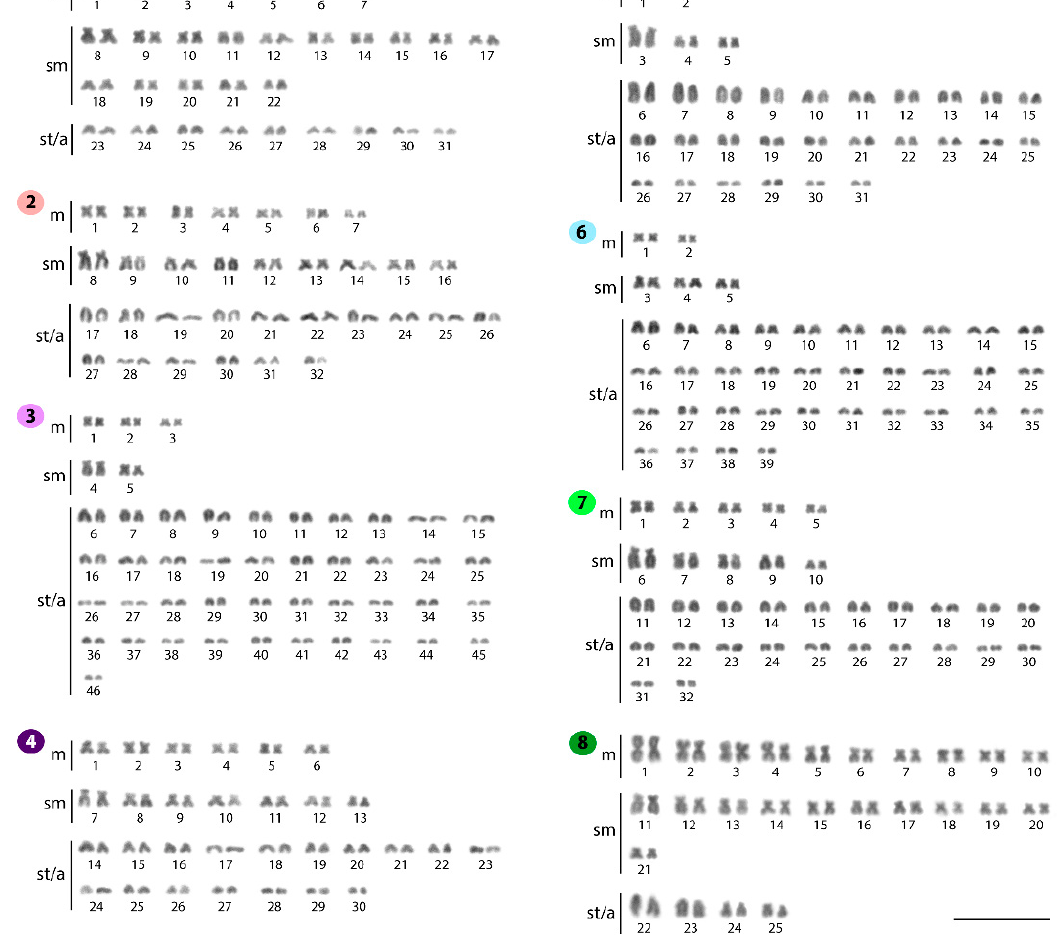
Figure 1. Karyotypes of Belodontichthys truncates ( 1 ); Kryptopterus bicirrhis ( 2 ); Kryptopterus geminus ( 3 ); Kryptopterus limpok ( 4 ); Kryptopterus macrocephalus ( 5 ); Micronema cheveyi ( 6 ); Ompok fumidus ( 7 ); and Ompok siluroides ( 8 ) arranged following Giemsa-staining. Bar = 5 µm.